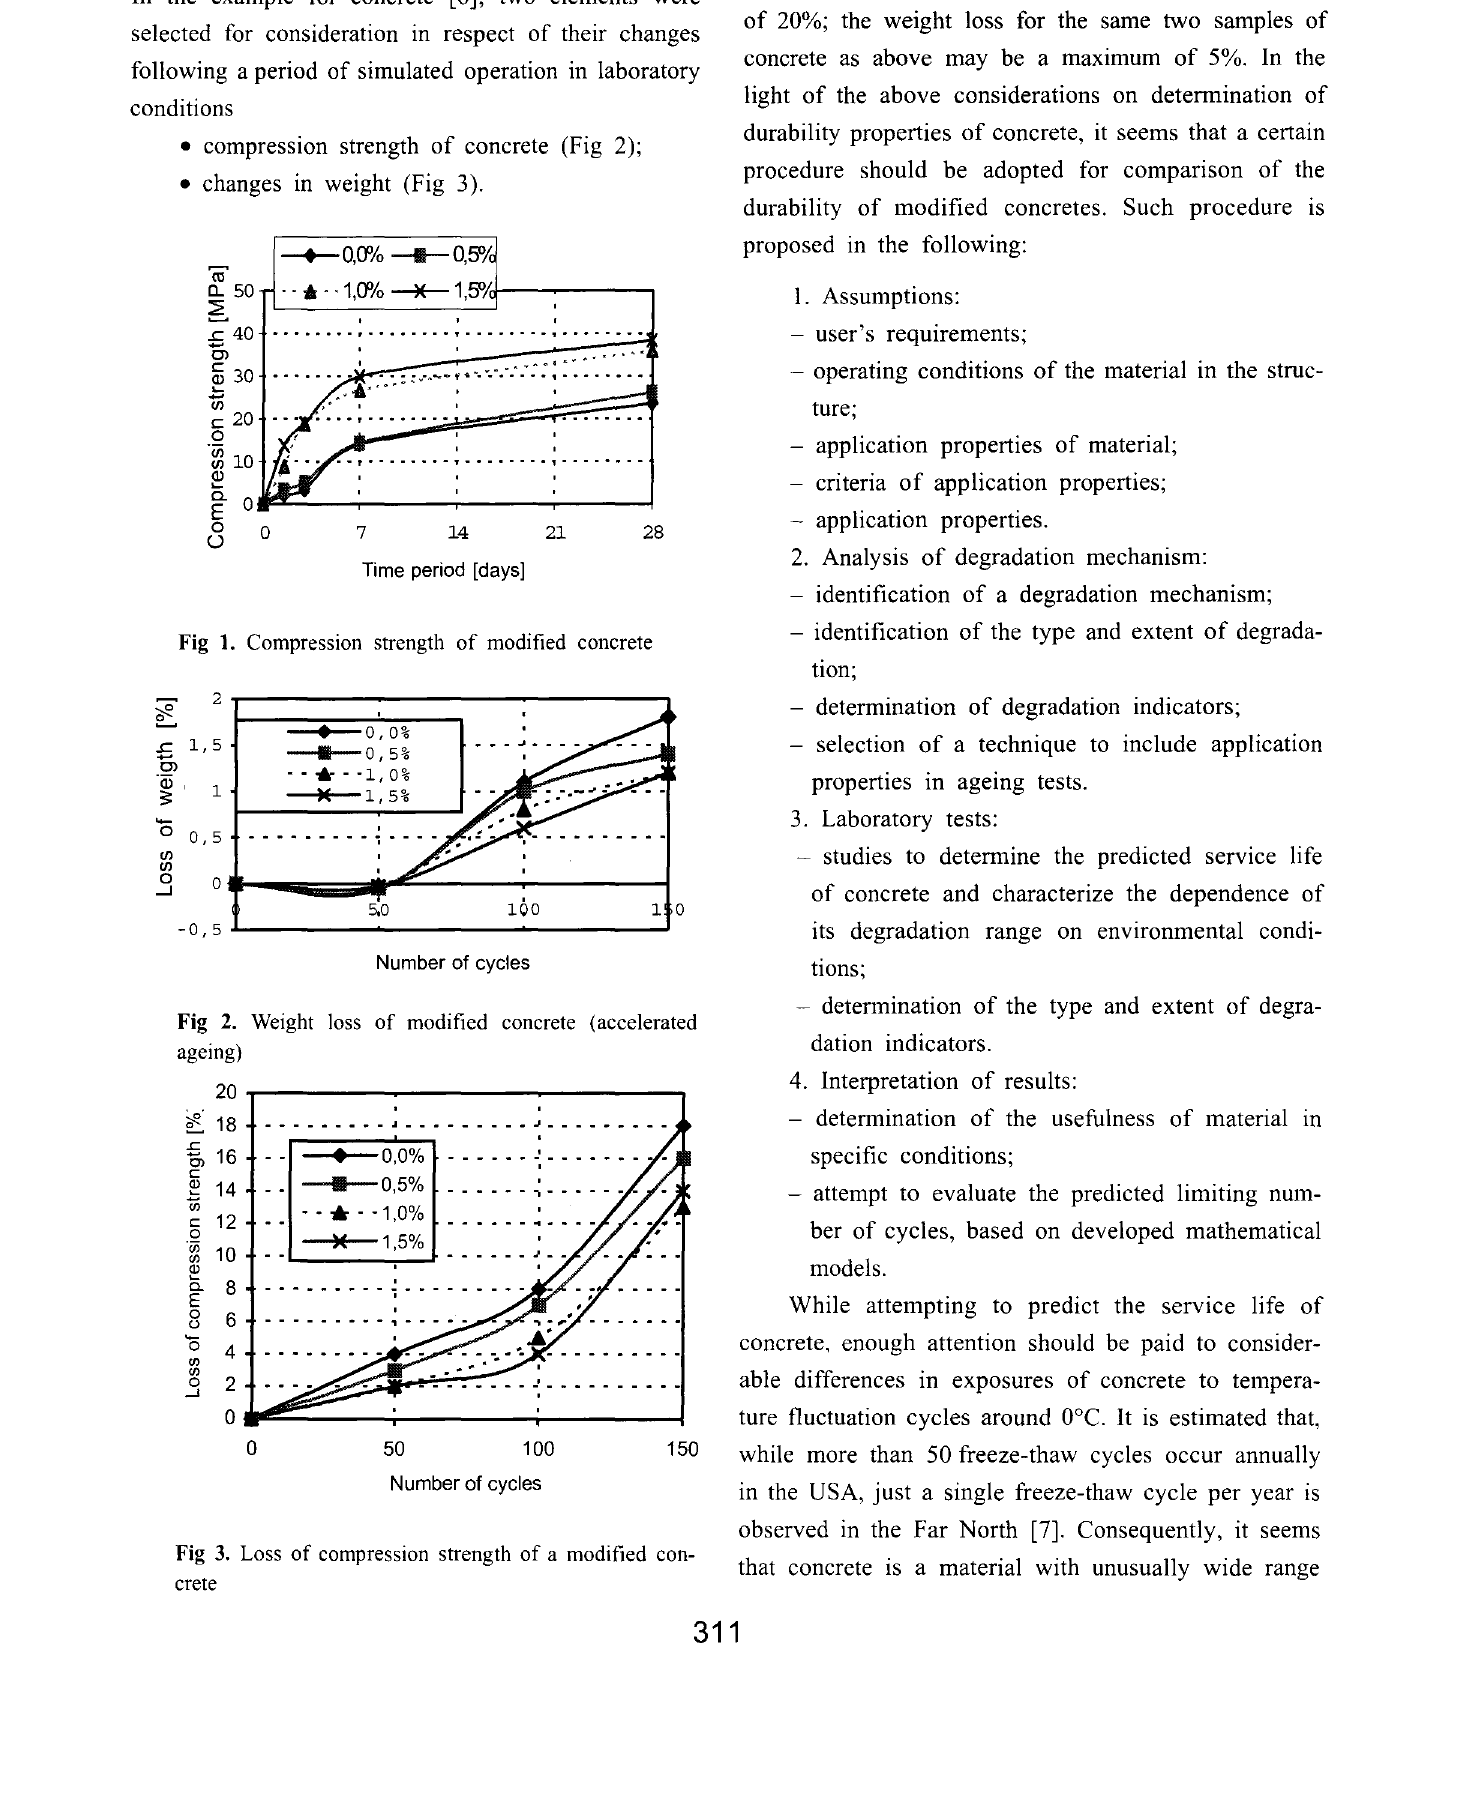
Fig 1. Compression strength of modified concrete